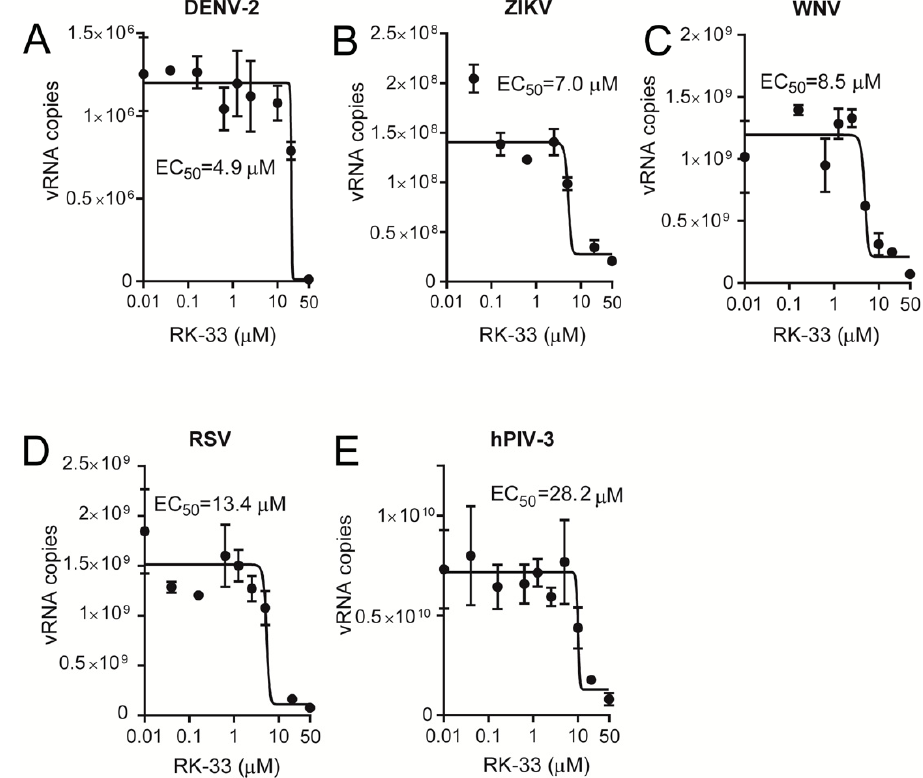
Figure 4. RK-33 is a broad-spectrum inhibitor of virus replication. Vero cells were infected with ( A ) DENV-2, ( B ) ZIKV, ( C ) WNV, ( D ) RSV or ( E ) hPIV-3 at an MOI of 1 for 2 h, after which virus was removed, and fresh medium containing 2% FBS or 2% FBS supplemented with the indicated concentration of RK-33. Released virus samples (for hPIV-3, DENV-2, ZIKV and WNV) or cell-associated samples (for RSV) were collected 22 h later, and viral RNA (vRNA) copies determined by qRT-PCR. Dose-response curves were plotted from the vRNA copies versus the logarithmic value of the concentrations of RK-33. Results represent the mean +/ − SD for duplicate wells from a single assay, representative of two (n = 2) independent experiments. See Table 1 for pooled data from the two assays.